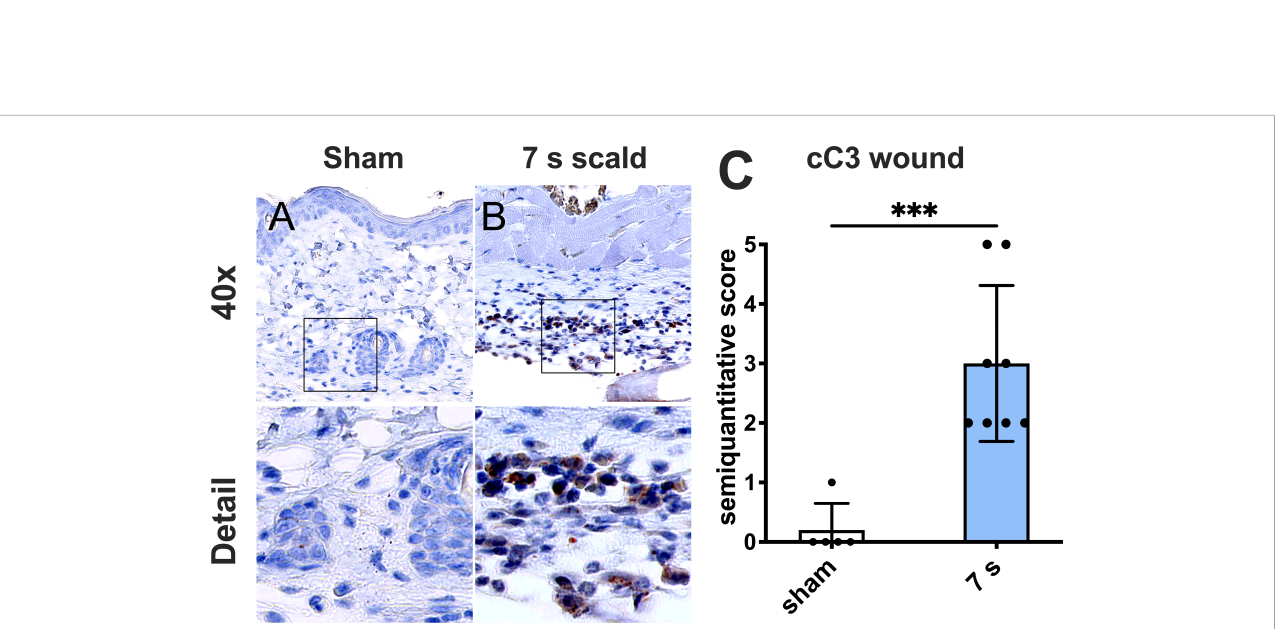
FIGURE 5 A 7 s scald injury induces dermal apoptosis after 24 h. Representative images of IHC staining for cC3 are shown for sham (A) and 7 s scald (B) . Semiquantitative score (C) revealed a signi fi cant upregulation of cC3 in the subcutaneous connective tissue in 7 s scald compared to sham. Results are provided as mean ± SD. For comparison, an unpaired t -test was performed. The level of signi fi cance: ***p < 0.001.